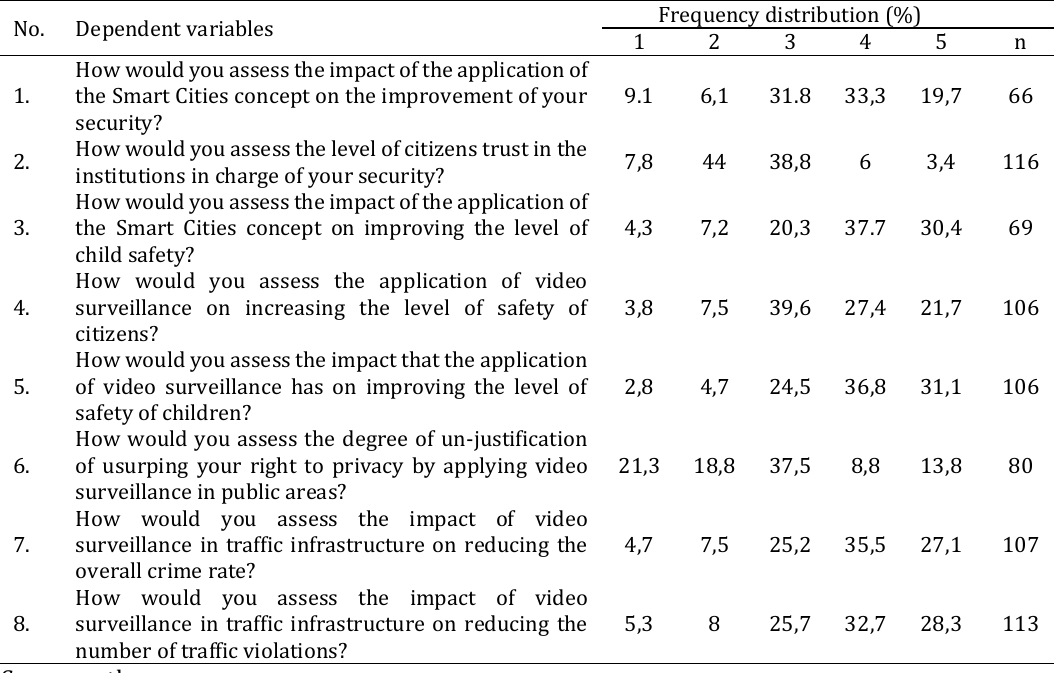
Table 2. Results of the respondents' opinions (scale of